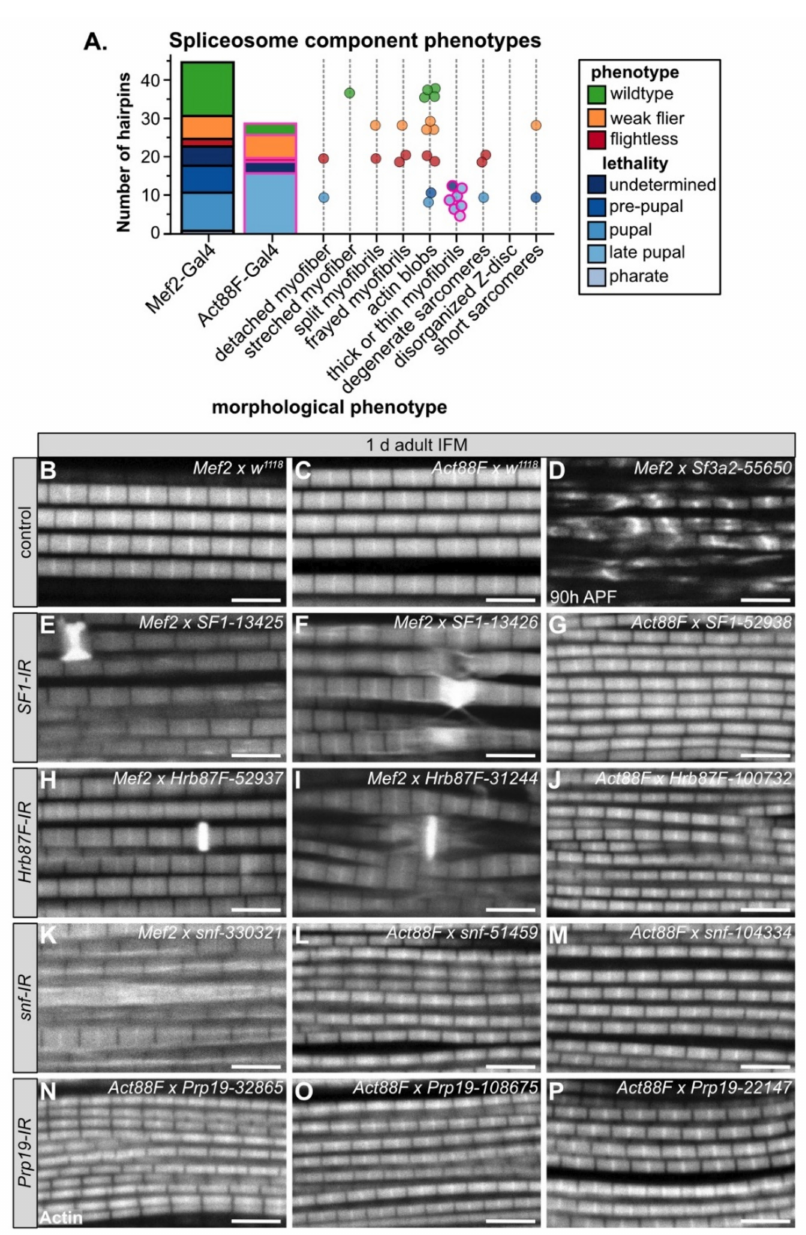
Figure 5. Knockdown of spliceosome core and associated components produces distinctive myofibril and sarcomere phenotypes. ( A ) Graphical summary of lethality, flight and confocal phenotypes for Mef2-Gal4 (black outline) and Act88F-Gal4 (magenta outline) knockdown with 44 hairpins targeting 17 spliceosome genes. Dots represent hairpins and are colored by flight (flightless, red; weak flier, orange) and lethality (blue shades) phenotype. Hairpins may appear in more than one morphological phenotype category. ( B – P ) Single-plane confocal images of 1 d adult IFM showing w 1118 controls ( B , C ) and phenotypes for three hairpins each targeting A-complex components SF1 ( E – G ) and Hrb87F ( H – J ), A- and B-complex component snf ( K – M ) or B-, C- and P- complex compo- nent Prp19 ( N – P ). A more severe phenotypic example at 90 h APF with knockdown of Sf3a2 ( D ) is provided for comparison. Mef2-Gal4 knockdown phenotypes are variable, ranging from degenerate ( D,K ), split ( D,I ) and frayed myofibrils ( D,F ) to short sarcomeres ( D,F,I ) and actin blobs ( D – F,H – I ). Act88F-Gal4 knockdown of spliceosome components results in thin myofibrils ( G, I – J,K – M,P ). The knockdown efficiency as well as developmental timing influence phenotypic severity. Scale bars = 5 µ m; phalloidin stained F-actin,